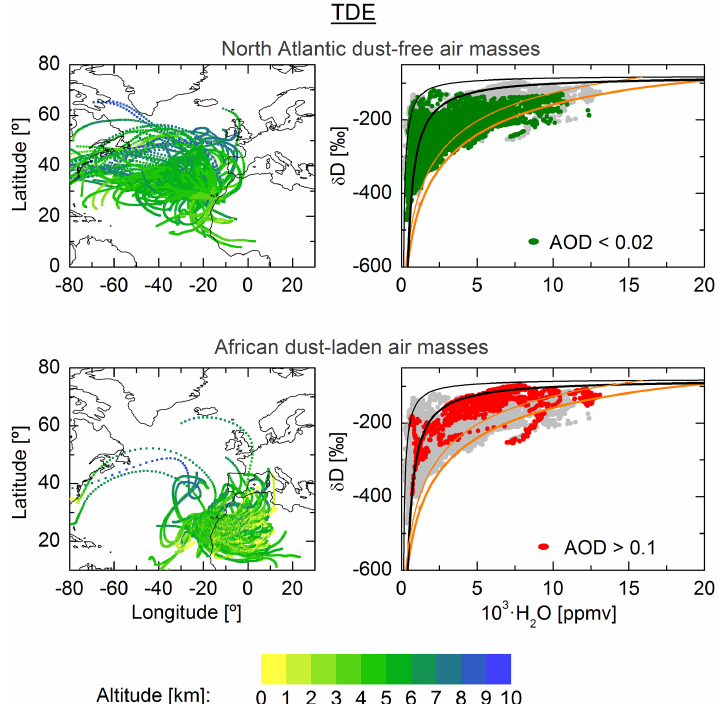
Figure 6. Same as Fig. 5 for the data collected at TDE